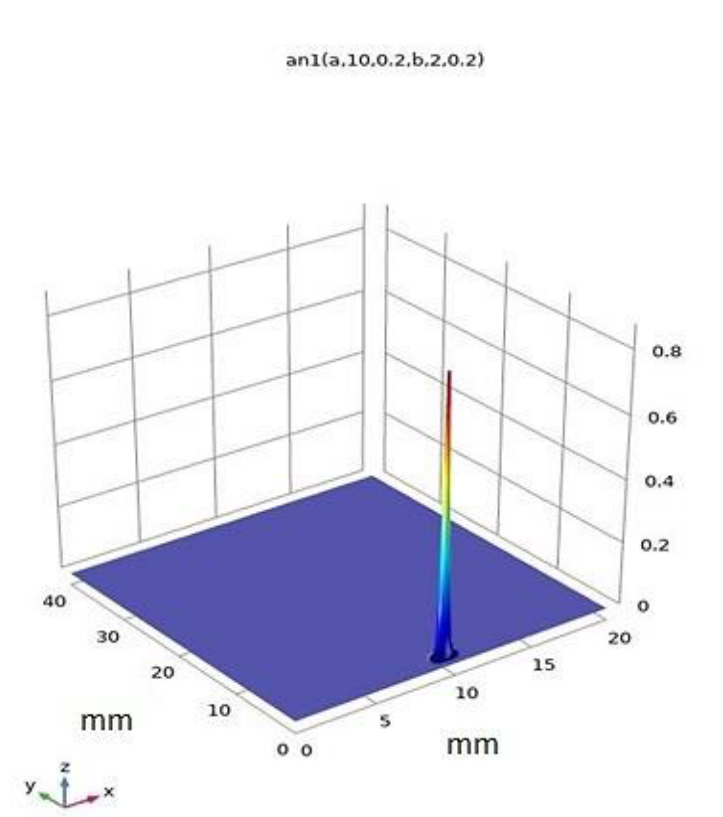
Figure 2. Profile of Hermit–Gaussian heat source function.